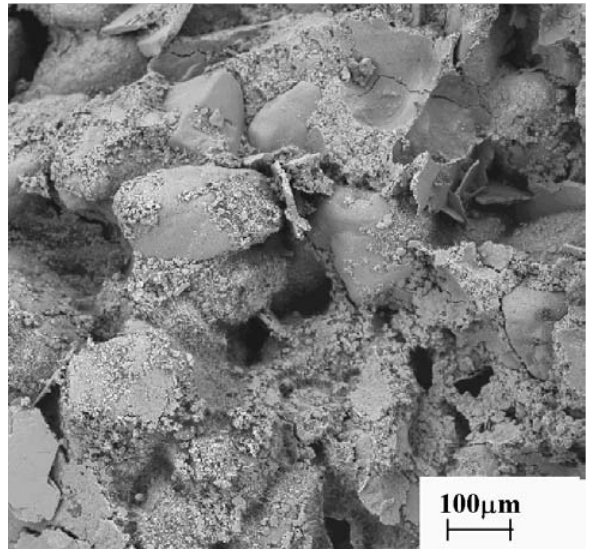
Figure 10. SEM micrograph of a general view of the (J) samples (CPI- S-32 cement/5% bottom ash/sand) after 28 days of aging.